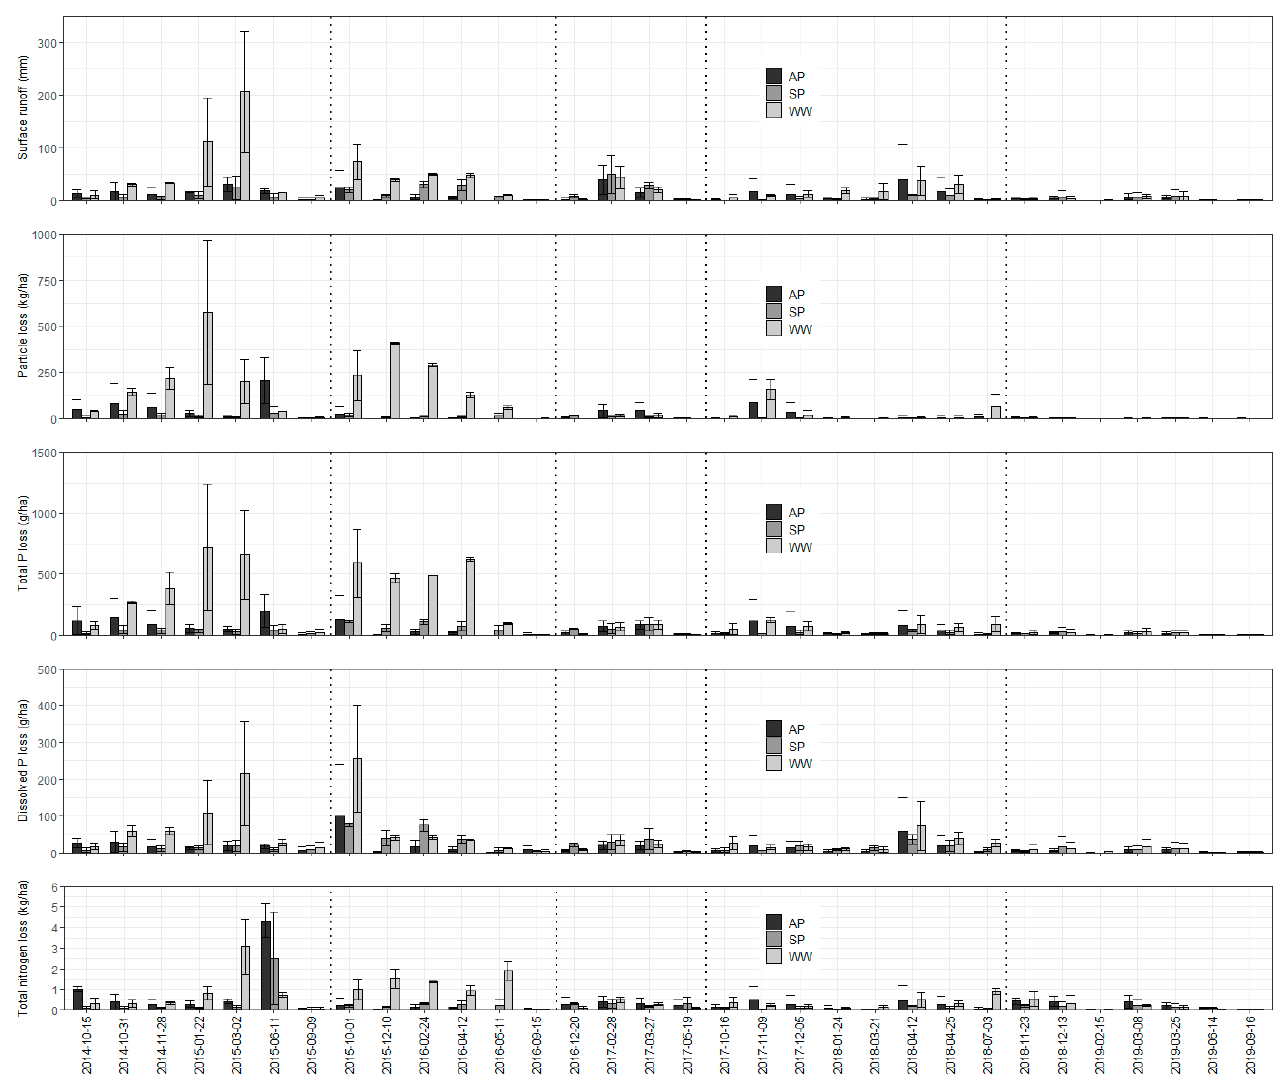
Figure 2. Averages values for each tillage practice (AP, WW, SP) for surface loss of soil and nutrients, measured surface runoff (mm), precipitation (mm) and the dates when the samples were taken. Years are separated by dashed lines.